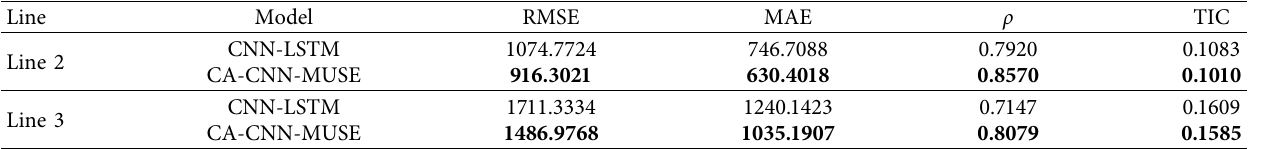
Table 2: Performance on diferent lines.